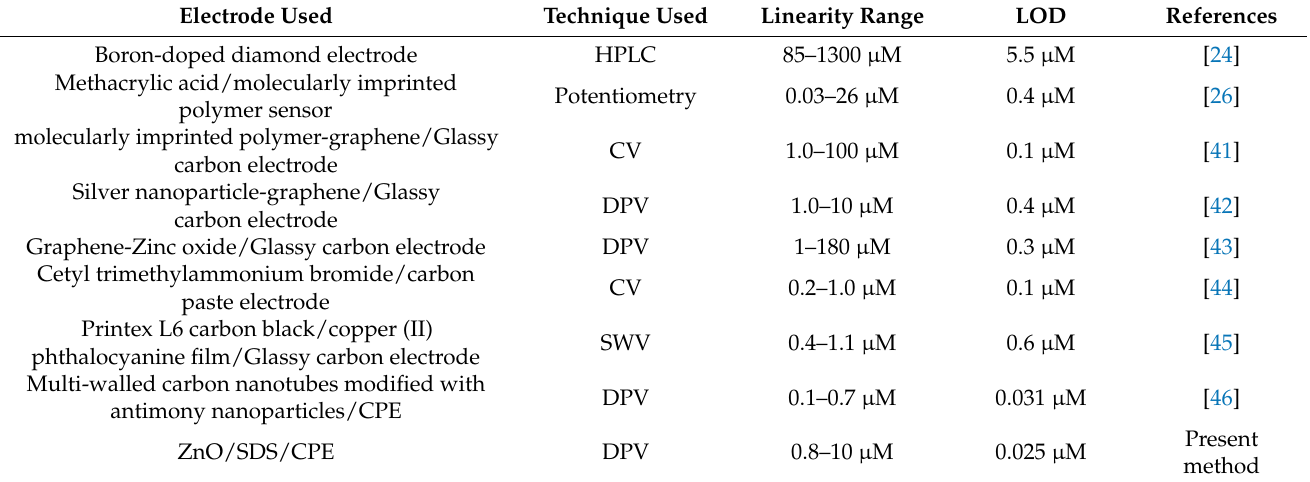
Table 1. Comparative study of detection limit of TMP.